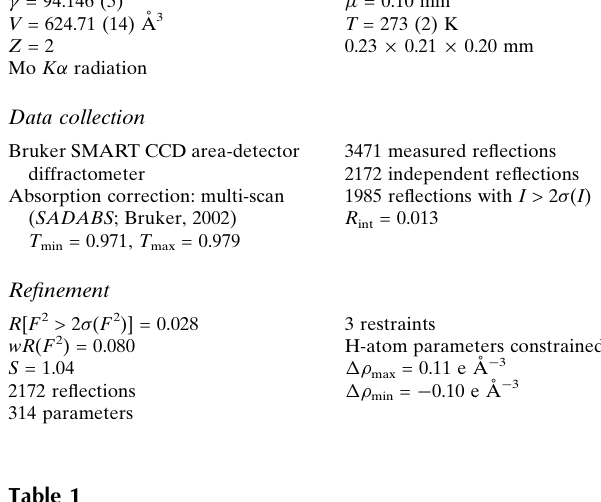
Hydrogen-bond geometry (A˚ , (cid:2)